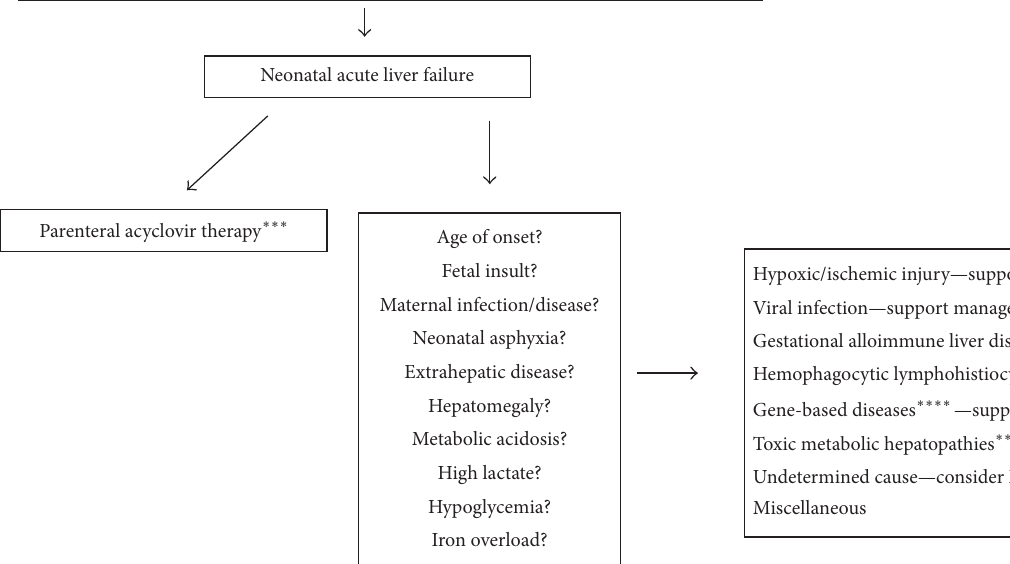
Figure1:Simplifieddiagnosticandmanagementalgorithmforacuteliverfailureinneonates. ∗ PTisprothrombintime; ∗∗ INRisinternational normalized ratio; ∗∗∗ herpes simplex virus is the most common virus associated with NALF with high mortality rate without early initiation of treatment (cutaneous findings are uncommon); ∗∗∗∗ includes respiratory chain defects, errors in fatty acid oxidation, and mitochondrial DNA depletion syndromes; ∗ ∗ ∗ ∗ ∗ includes hereditary tyrosinemia type 1, galactosemia, and hereditary fructose intolerance; ∗∗∗∗∗∗ ET is exchange transfusion; ∗∗∗∗∗∗∗ IVIG is intravenous immunoglobulin (modified from Taylor and Whitington,